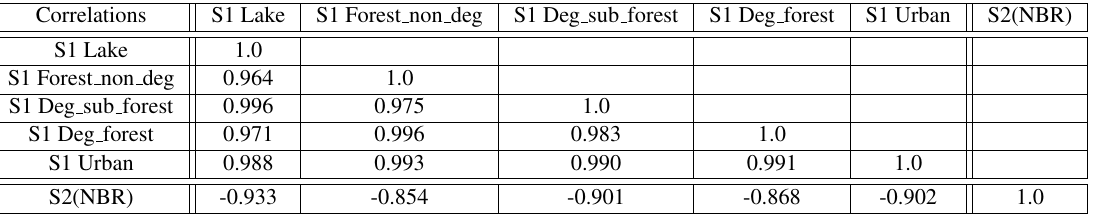
Table 2: Synergy between Sentinel-1 ( σ db VH) and Sentinel-2